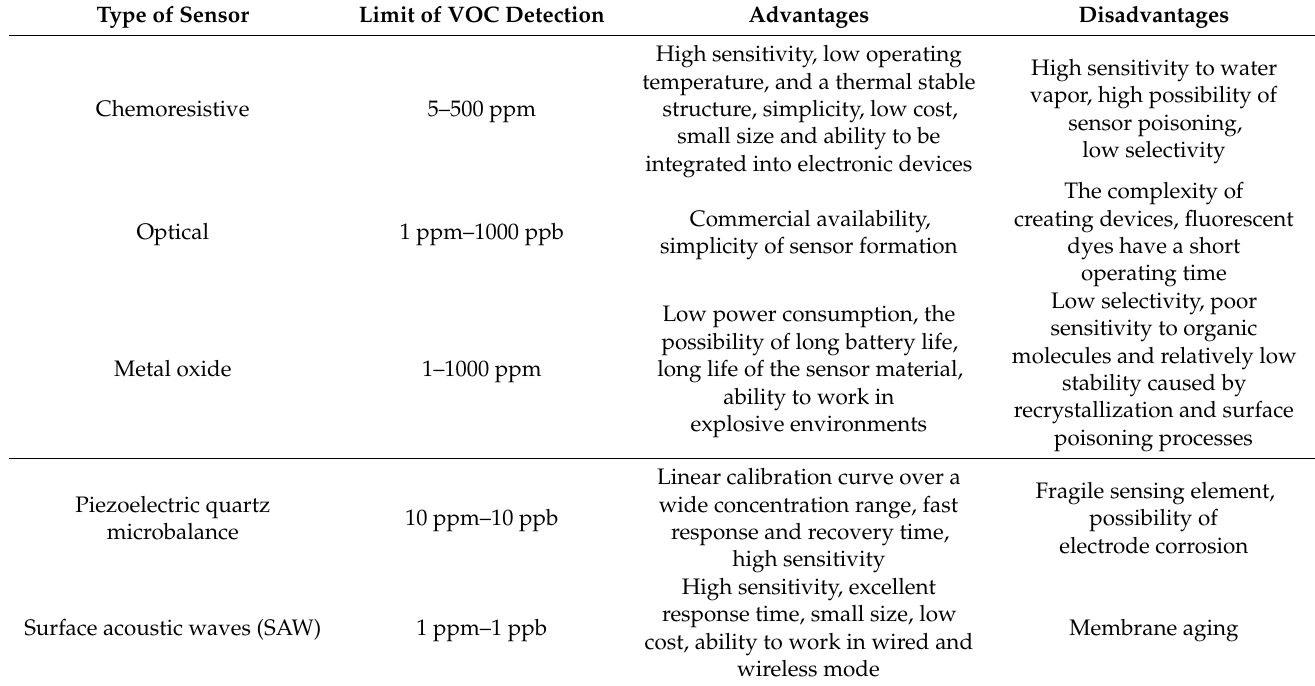
Table 1. Comparative characteristics of various types of